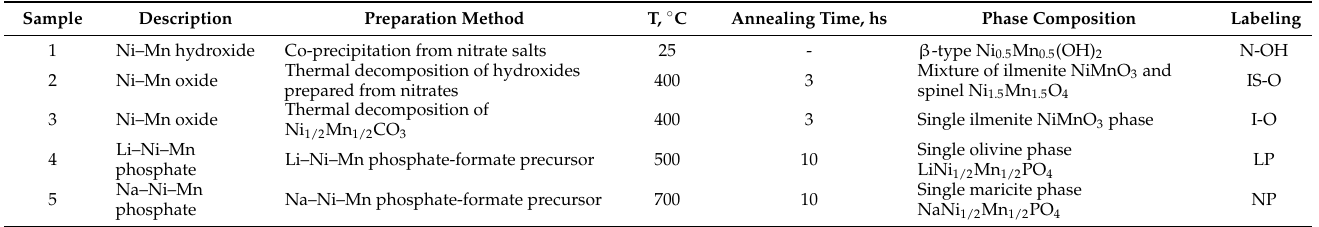
Table 1. Experimental conditions, preparation methods, phase compositions and labeling of the studied hydroxides, oxides and